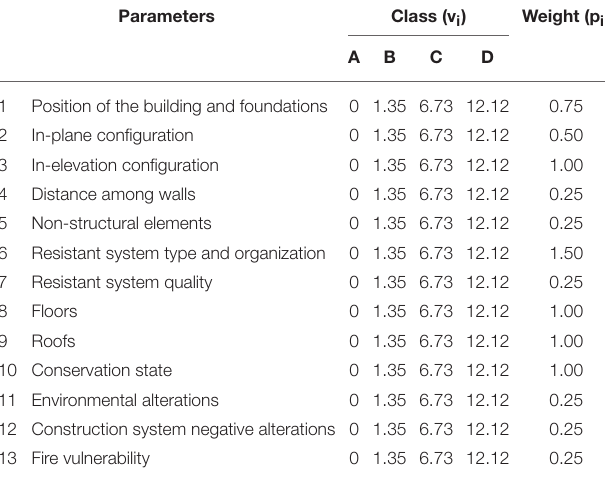
TABLE 2 | Parameter evaluation and quantification in order to calculate the vulnerability index.